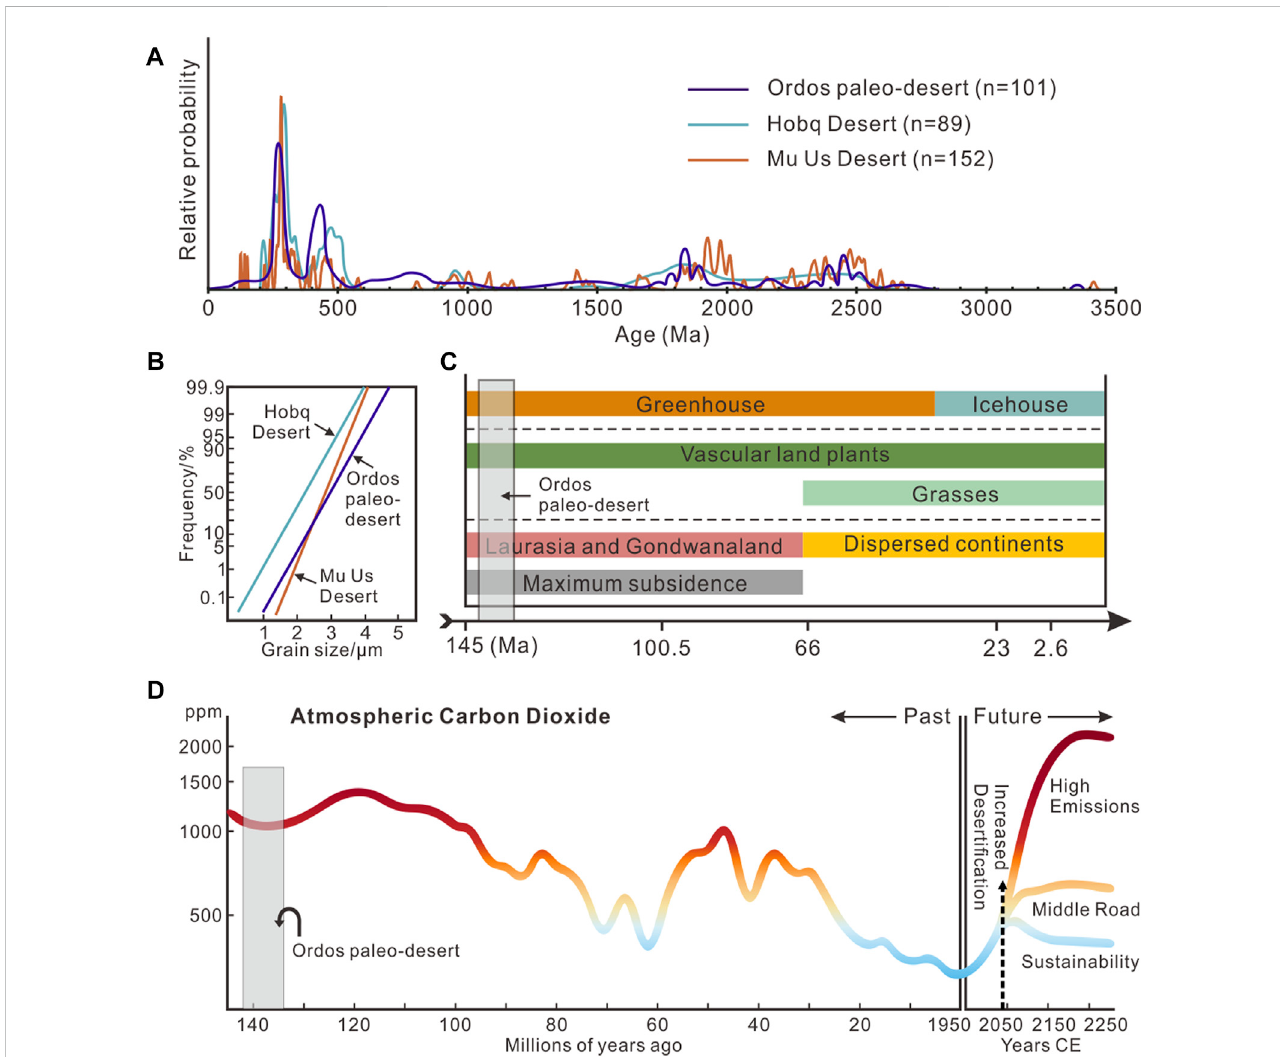
FIGURE 7 (A) U ‒ Pbage spectra of detrital zircons from theEarly Cretaceous paleo-desert, Hobq Desert and Mu Us Desert inthe Ordos Basin. Data sources: Ordos paleo-desert (Cheng et al., 2020); Hobq Desert (Yang et al., 2017); Mu Us Desert (Stevens et al., 2010). (B) Log-probability cumulative curves of grain-size distribution for aeolian sediments in the Ordos paleo-desert, Hobq and Mu Us Deserts. Data sources: Ordos paleo-desert and Mu Us Desert (Li et al., 1999); Hobq Desert (Zhang et al., 2018). (C) Climate, vegetation, basin subsidence and supercontinental setting governing aeolian construction, accumulation, and preservation from the Cretaceous to the present. Adapted from Cosgrove et al. (2021c). (D) Past carbon dioxide concentrations (left) compared to possible future emissions scenarios (right). Adapted from Tierney et al. (2020) and Meinhausen et al.